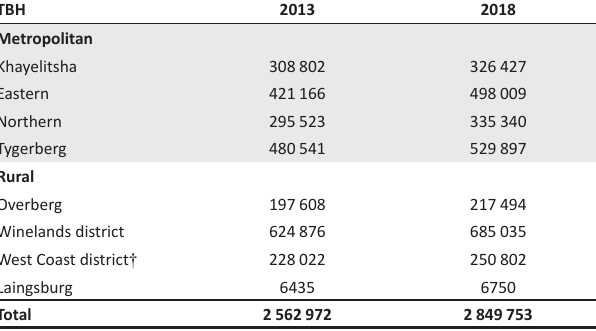
TABLE 2b: Western Cape Province Drainage populations 2013 and 2018 (dependent).